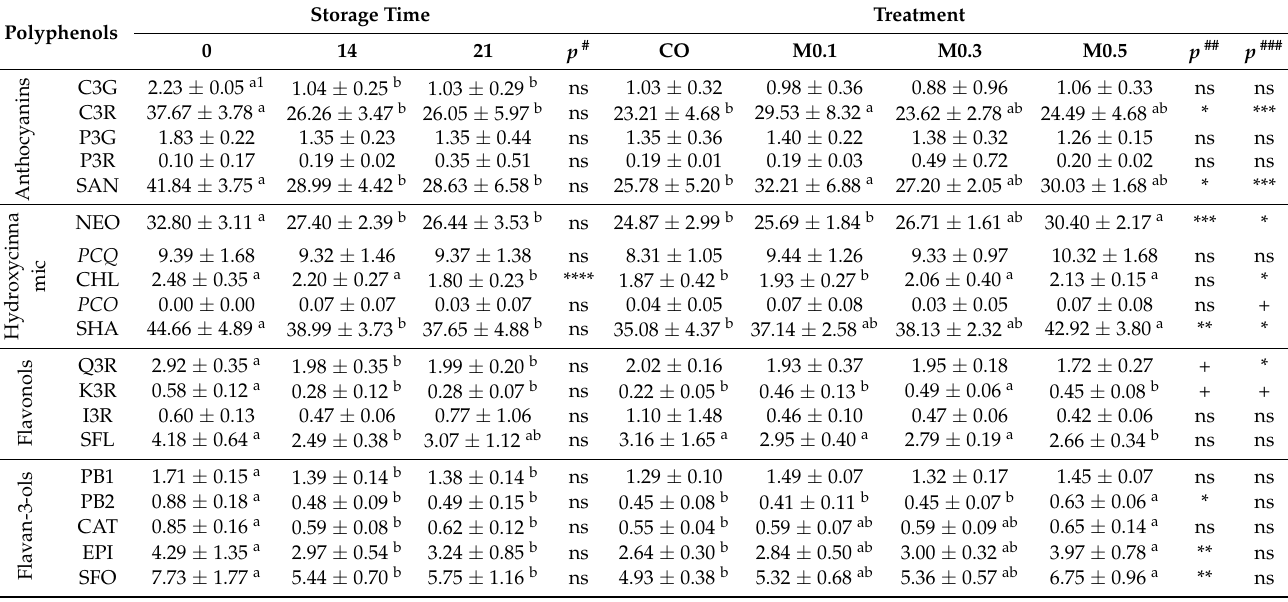
Table 4. Identification and quantification of phenolic compounds of ‘Samba’ sweet cherry in relation to storage time and treatments. Mean values 10 − 2 (g k − 1 ) ±